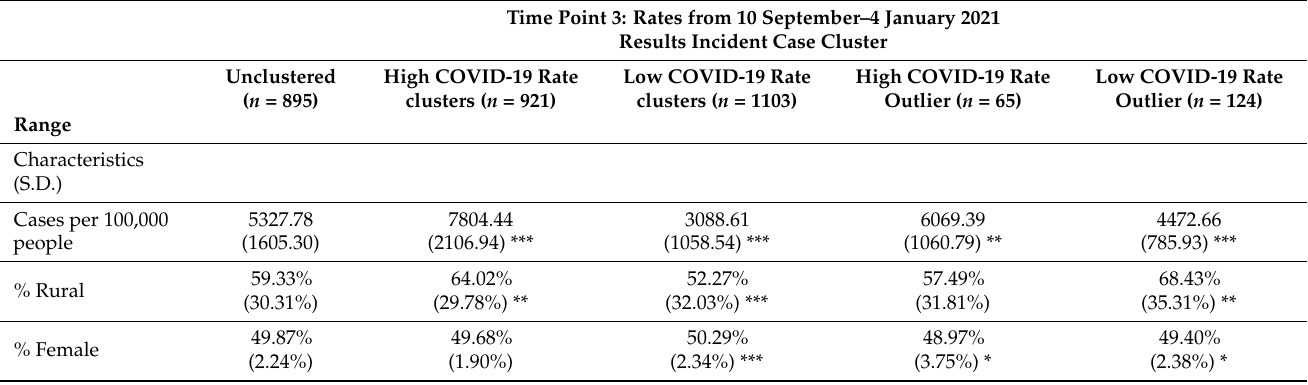
Table 3. County characteristics based on Anselin Moran’s I results for Time Point